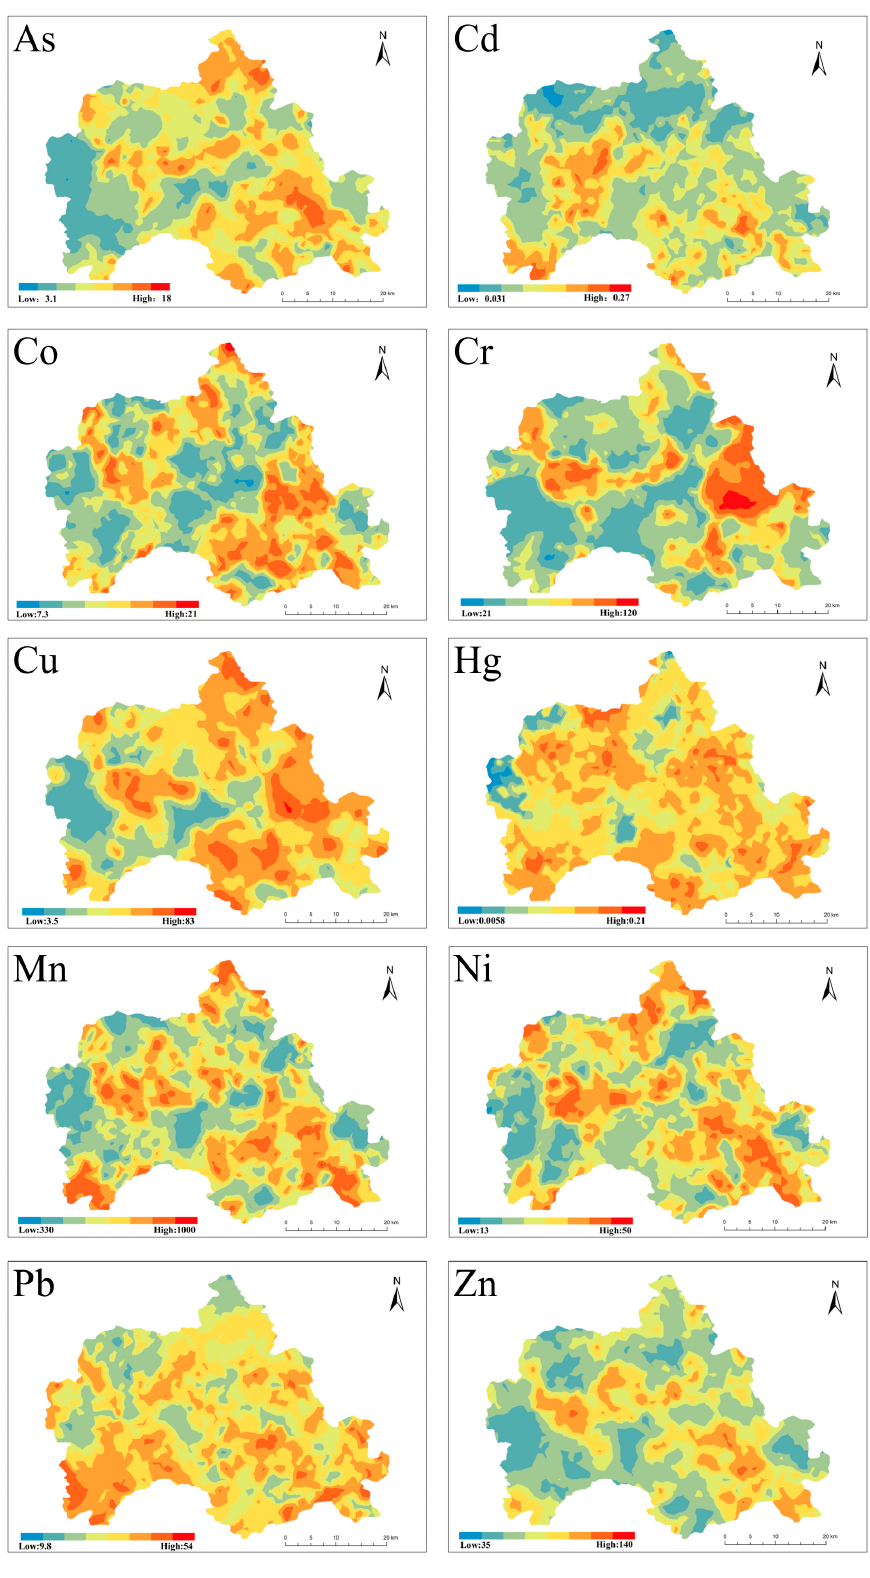
Figure 5. Soil heavy metals distribution map.